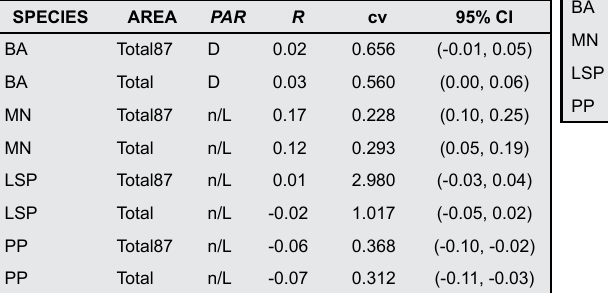
Table 8. Rate of increase/decrease in the survey area assessed using log-linear regression (LL method). “Total87” includes only those blocks covered in 1987. R – annual rate of increase; PAR – parame- ter used in determining R; D – Density; n/L – encounter rate. Species as in Table 2.